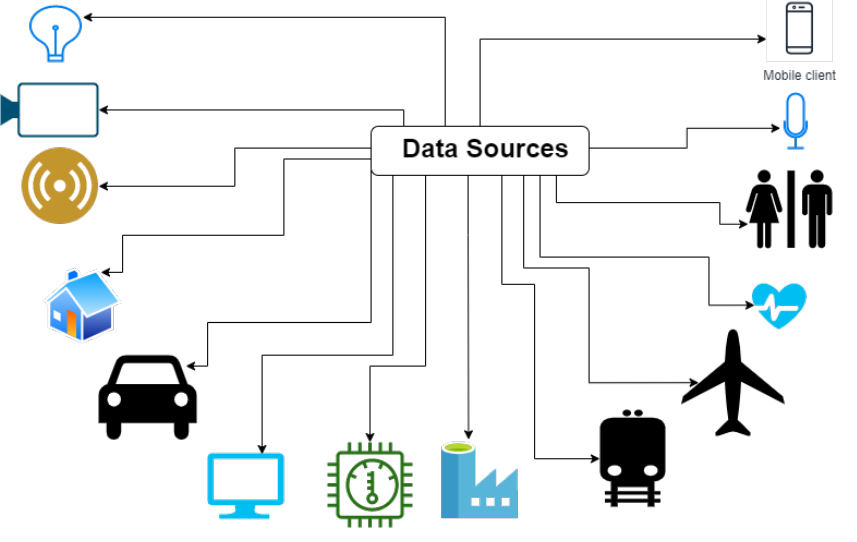
Figure 4. Data generation